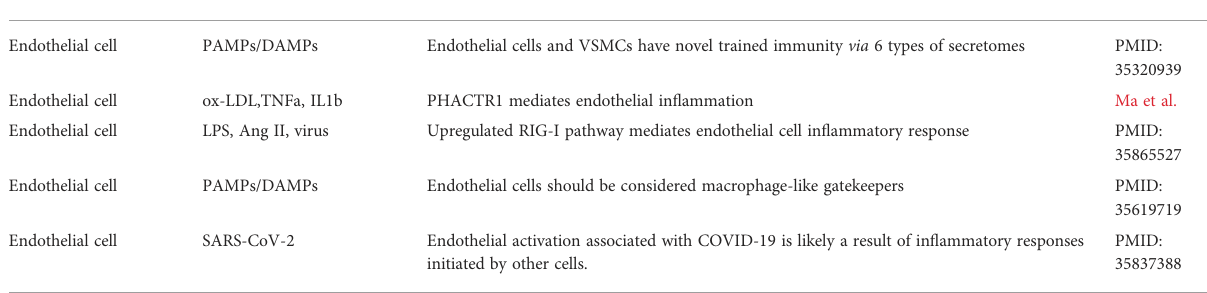
TABLE 1 Summary for 5 highlighted studies in Frontiers in Immunology: